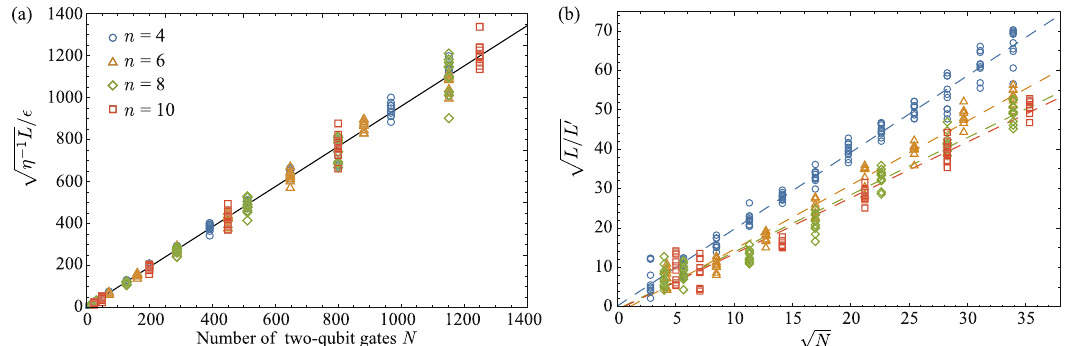
ffiffiffi p L before error